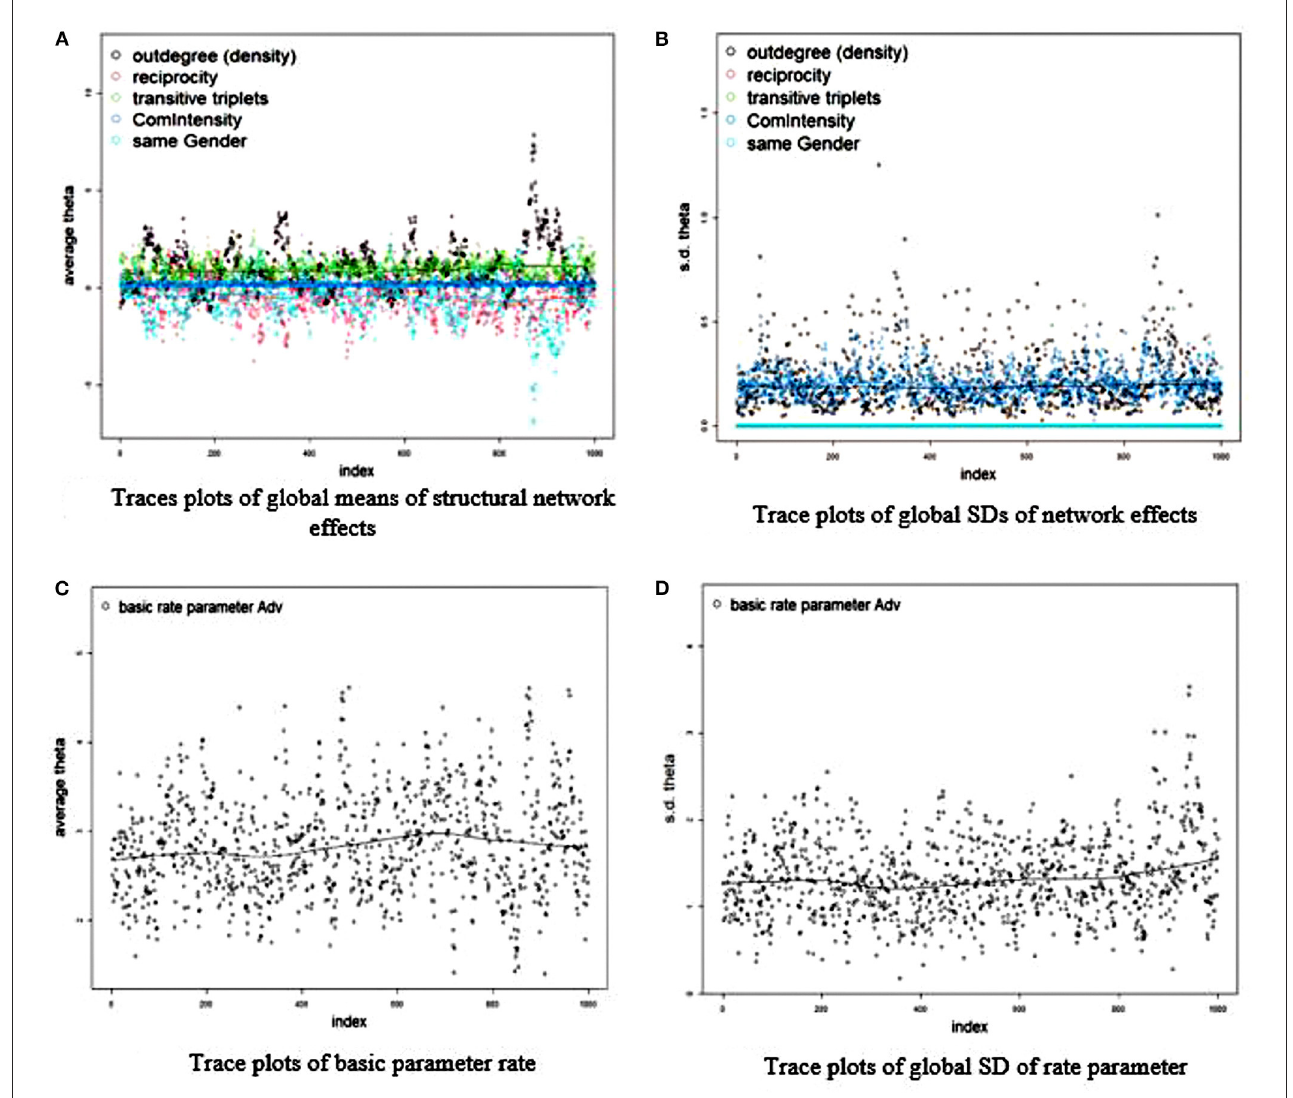
FIGURE4 (A–D) Trace plot for convergence diagnosis (good convergence). SD, standard deviation; Adv, name of key network; Theta, estimated coefficient; Index, iteration in estimation